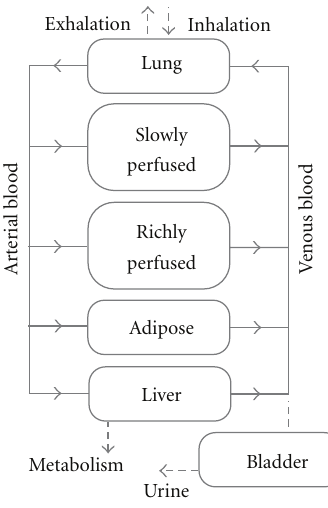
Figure 4: Schematic of the PBPK model for m -xylene with a bladder compartment, to simulate fluctuations in the concentration of the main metabolite, methylhippuric acid.